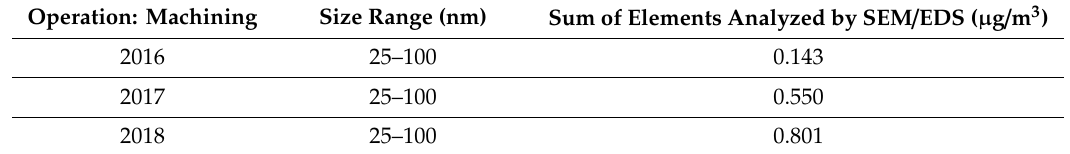
Table 3. Total mass concentration of elements subsequently analyzed by scanning electron microscope with energy-dispersive X-ray spectroscopy (SEM / EDS) during machining in the years